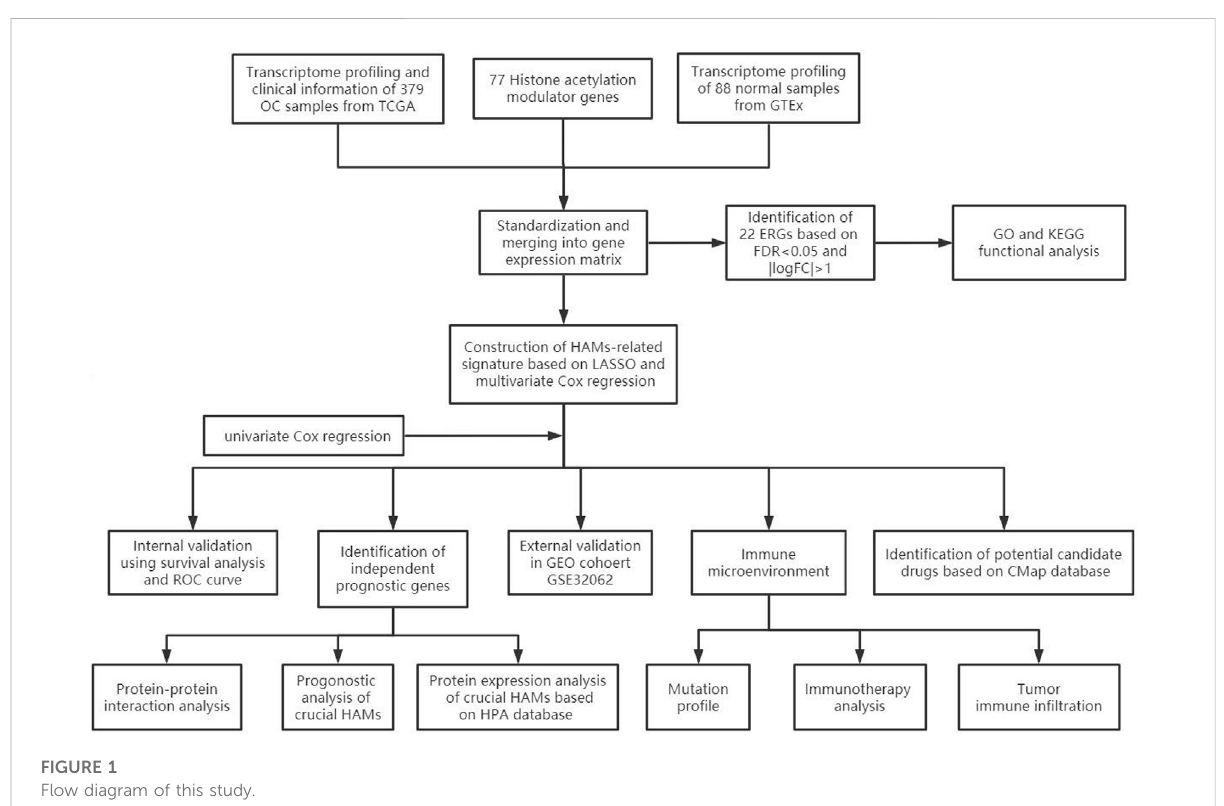
FIGURE 1 Flow diagram of this